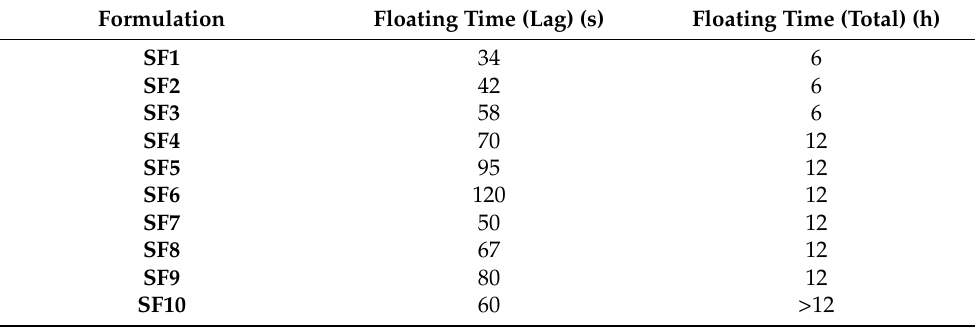
Figure 2. Floating time behavior at times ( a ) 0, ( b ) 55 s and ( c ) 60 s. Table 3. Buoyancy study.